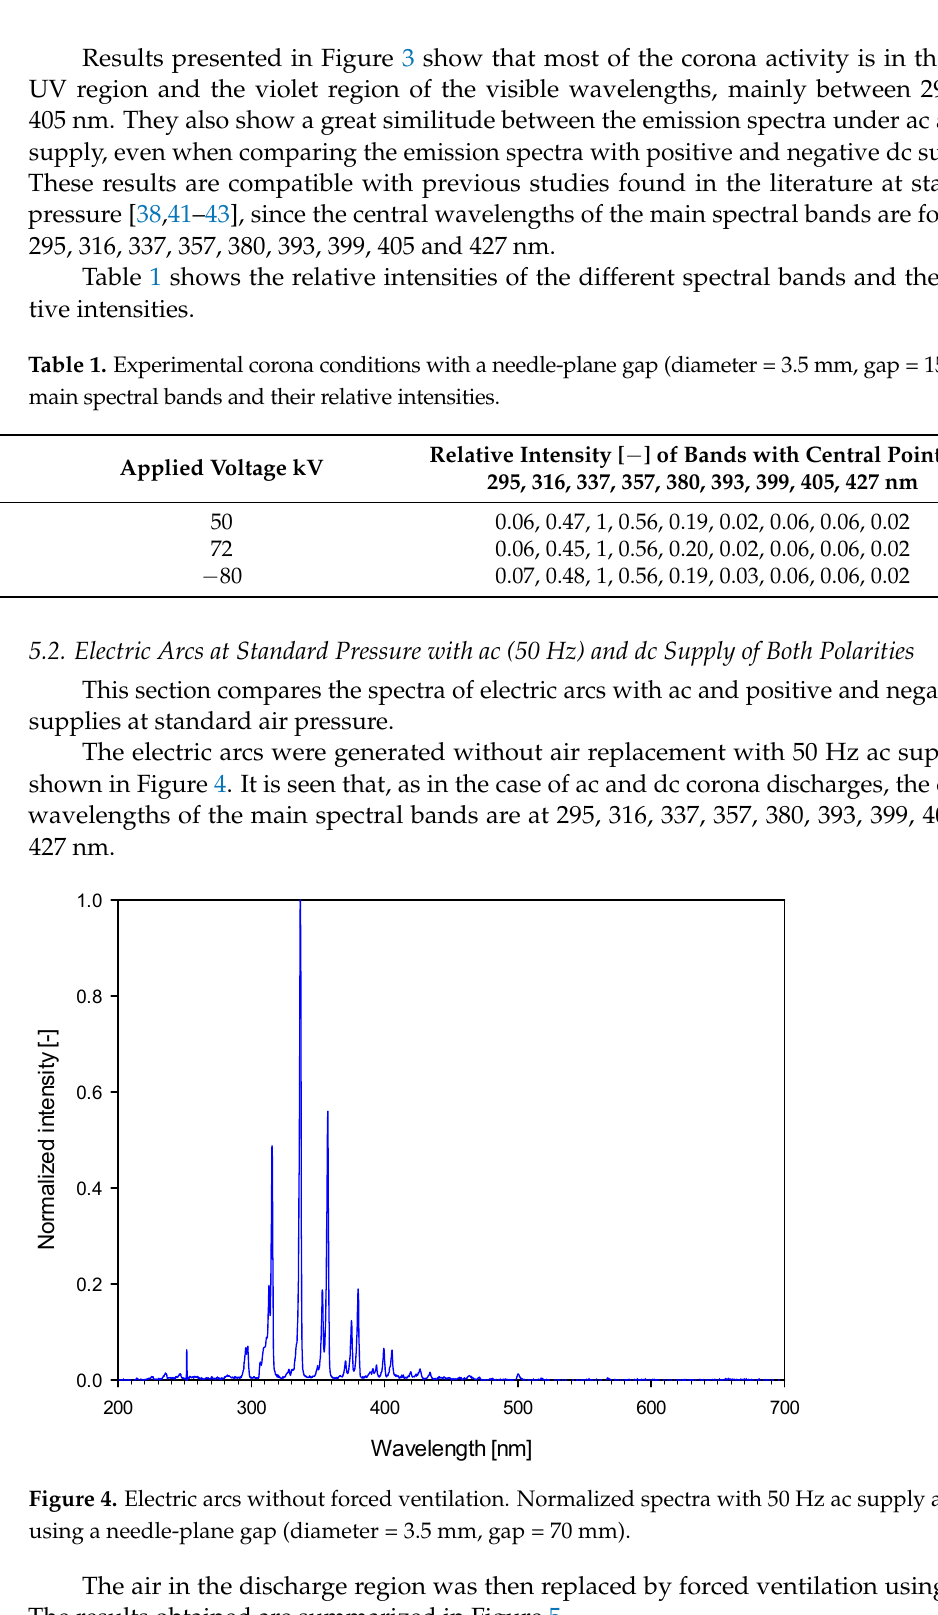
Figure 5. Electric arcs with forced ventilation (air replacement with fresh air). Normalized spectra of electric arcs with 50 Hz ac supply at 43 kV using a needle-plane gap (diameter = 3.5 mm, gap = 70 mm). As shown in Figure 5, the spectra of electric arcs with forced ventilation are more complex, having more components in the visible region compared to the spectra of corona discharges. According to [37,43] the emission spectra of excited molecules (N 2 *), ions (N 2+ *) and atomic radicals (N*, O*) also contain many bands within the entire visible and near-IR wavelength range. Emission spectra in the visible and near-IR regions are due to energy level transitions of outer electronics and the vibrations of chemical bonds of nitro- gen molecules excited by the intense electric field [41]. In the case of electric arcs with